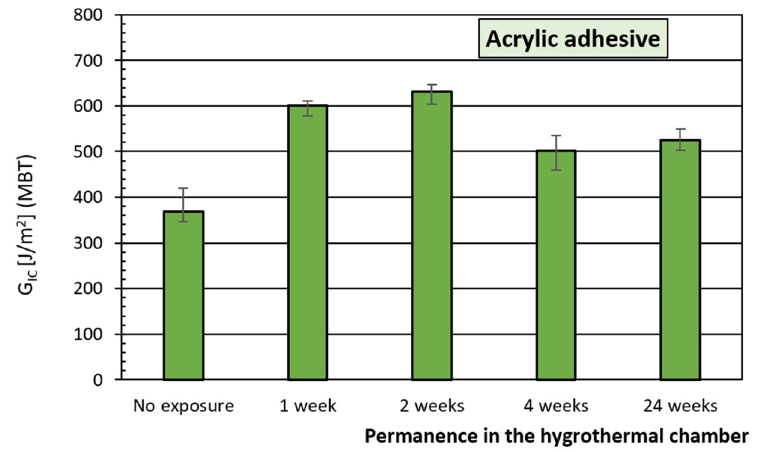
Figure 6. Evolution of the energy release rate under mode I of the adhesive with an acrylic base, hygrothermal loading.